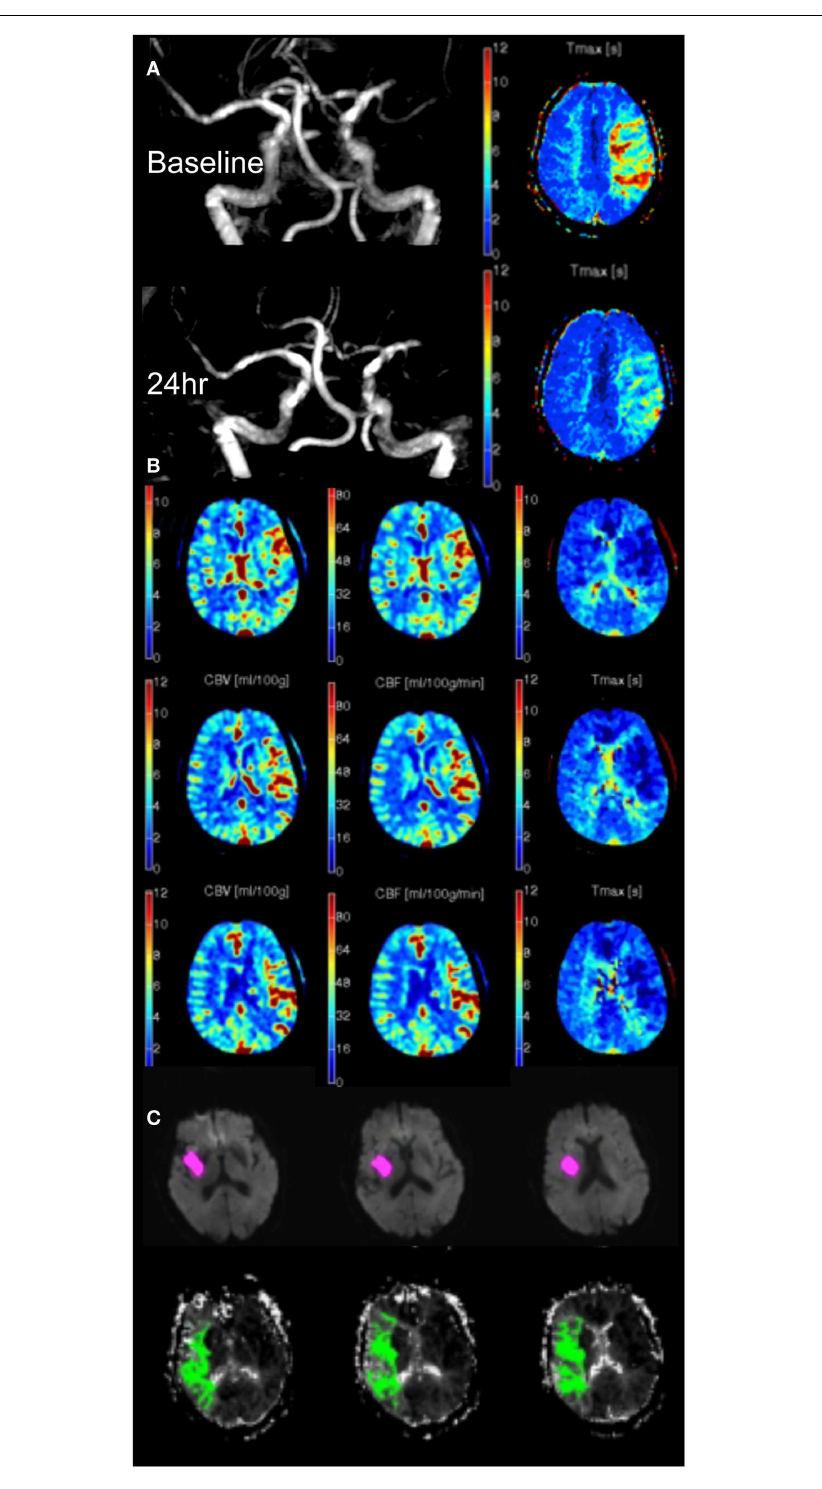
FIGURE 1 | (A) MRA and T max in a patient with left MCA occlusion at 5 and 24h. Despite persistent occlusion, the volume of T max > 6s has reduced from 56 to 0mL due to improved collateral supply. (B) Post-reperfusion hyperperfusion indicated by increased CBV (left), CBF (middle), and reduced T max (right) in a patient with recent reperfusion of left MCA occlusion. (C) MRI diffusion (pink) and perfusion ( T max > 6s, green) imaging 24h post-stroke onset showing persistent hypoperfused tissue, which was contributing to the patient’s clinical deficit but had not developed diffusion